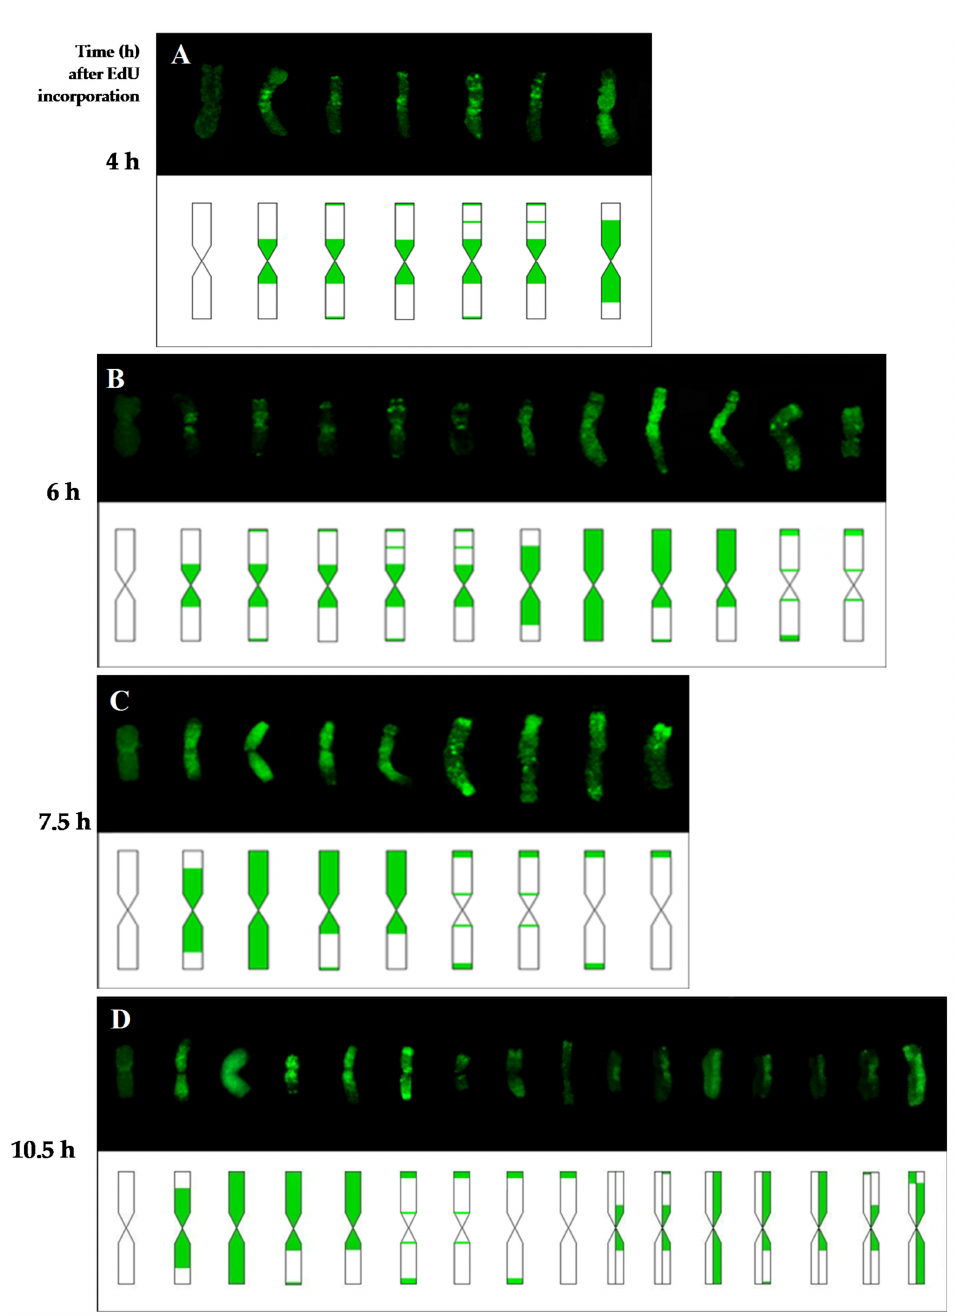
Figure 4. Types of replication patterns in barley chromosomes in the control roots at 4 h ( A ), 6 h ( B ), 7.5 h ( C ), and 10.5 h ( D ) after EdU incorporation. Chromosomes with different replication patterns and their corresponding schematic presentation are shown. Only one morphological type of chromosome is presented in order to simplify the scheme. After treatment with maleic hydrazide, only six replication patterns were observed. Figure 5 shows the different replication patterns in the MH-treated root at 10.5 h. No replication signals were observed at the earlier time points. Fully labeled chromosomes were the most frequently